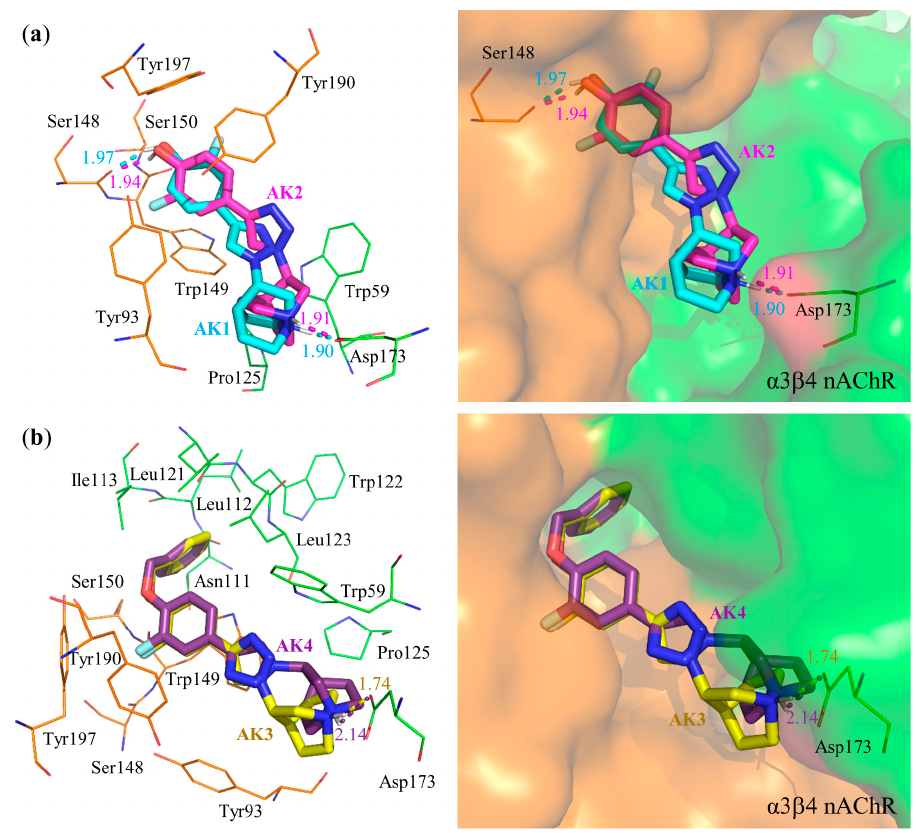
Figure 3. The overlay binding modes and molecular interactions of ( S )- and ( R )-enantiomers at the binding site of α 3 β 4 nAChR: docked conformations of ( a ) AK1 (cyan) and AK2 (magenta) and ( b ) AK3 (yellow) and AK4 (violet). Orange and green indicated residues in α 3 -principal and β 4 -complementary subunits, respectively.